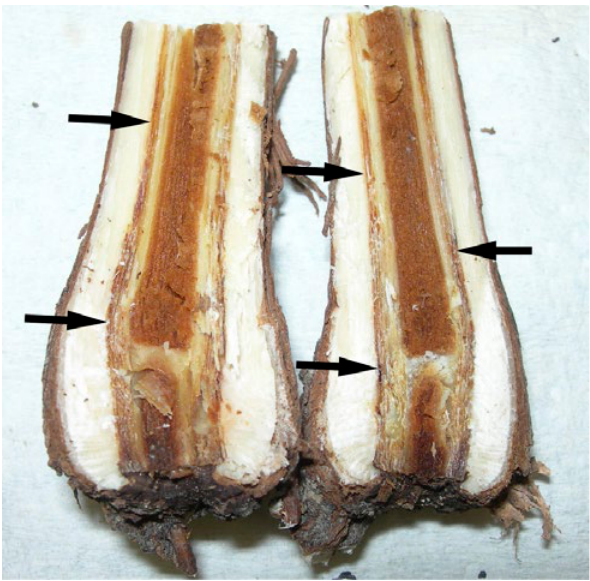
Figure 1. The sites in a grapevine rootstock base from which black foot disease pathogens were isolated (black arrows). Brown discolouration and streaking can be observed in the xylem